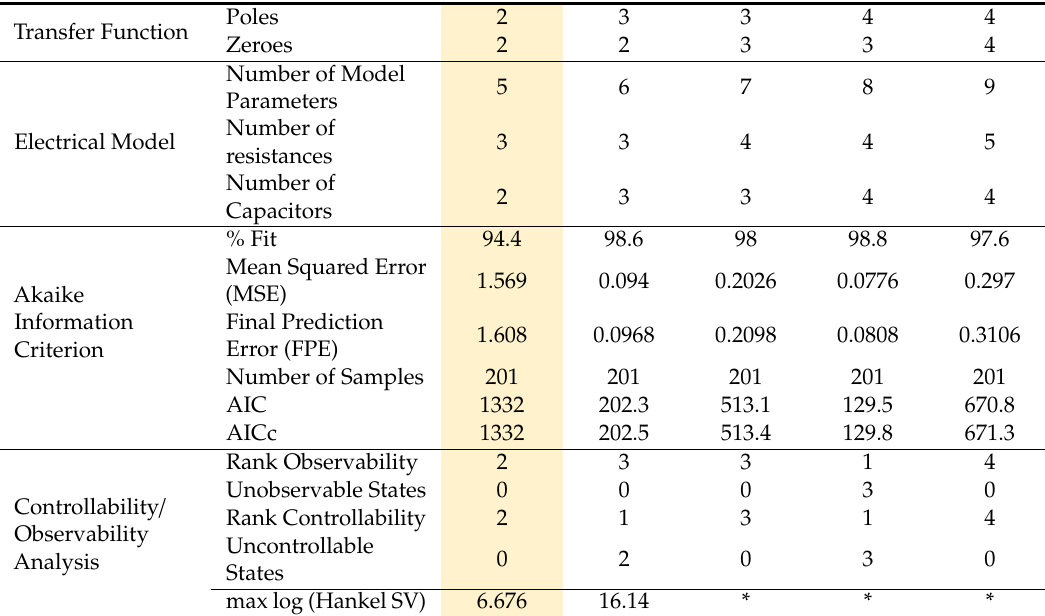
Table 4. Summary of model estimation for